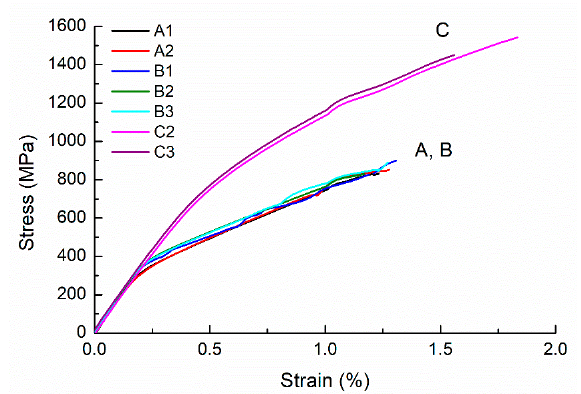
Figure 5. Stress–strain curves of SLM AISI 420 built in three directions. (A, B, and C denote the specimens built along the thickness, width, and length directions, respectively, as shown in Figure 2. A1, A2, and others individually represent each specimen ID number).